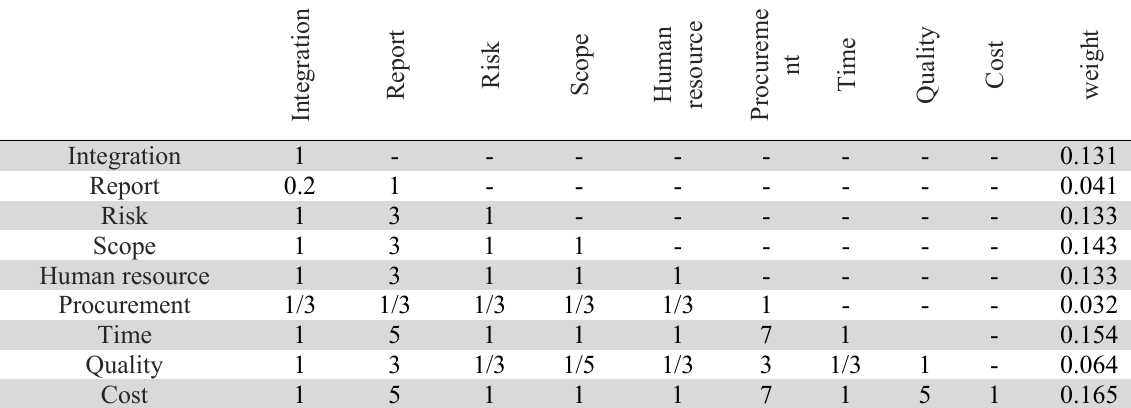
Comparisons in second level, project management